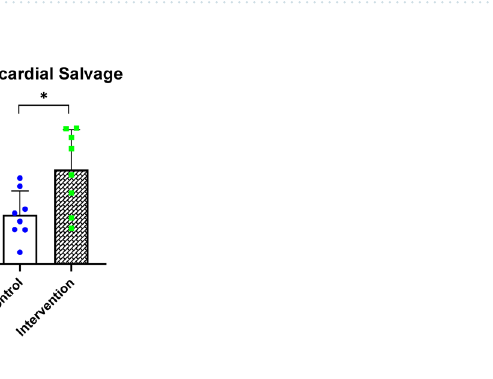
Figure 3. Differences in area at risk, infarct size and myocardial salvage between control and intervention group. The intervention group had significantly smaller infarct size and larger myocardial salvage with similar area at risk. Values are plotted as mean values, error bars represent standard